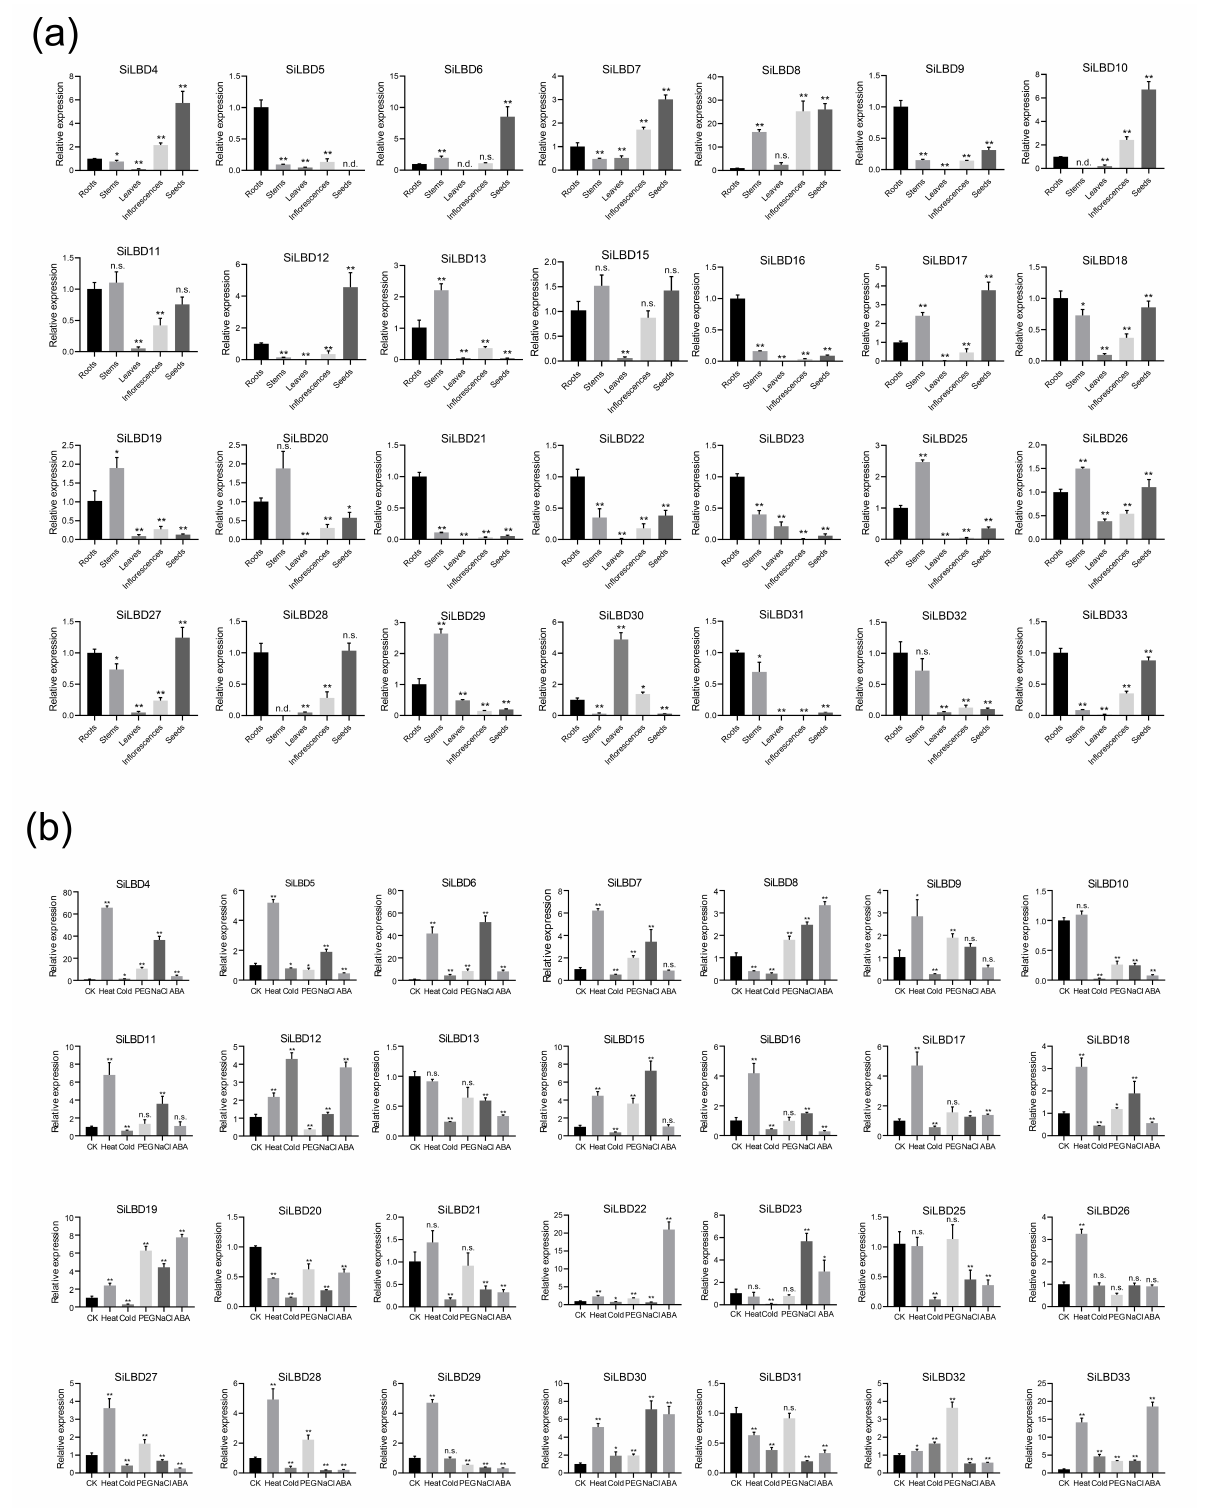
Figure 5. The expression patterns of SiLBD genes. ( a ) Expression patterns of SiLBD genes in different organs. ( b ) Expression patterns of SiLBD genes in 2-week seedlings treated by different stresses. CK in ( b ) indicates control. Error bars represent standard deviations, and statistically significant difference are indicated: ‘*’, 0.01 < p ≤ 0.05; ‘**’, p ≤ 0.01; ‘n.d.’, no detection; ‘n.s.’, no significance (Student’s t